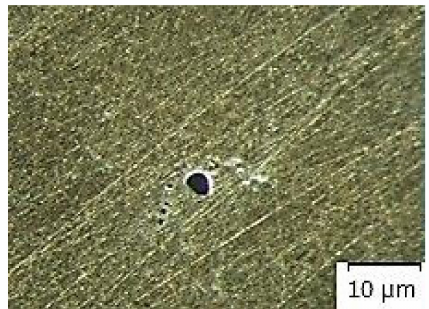
Figure 7. Microscopic evaluation of sample 1/ × 100/.